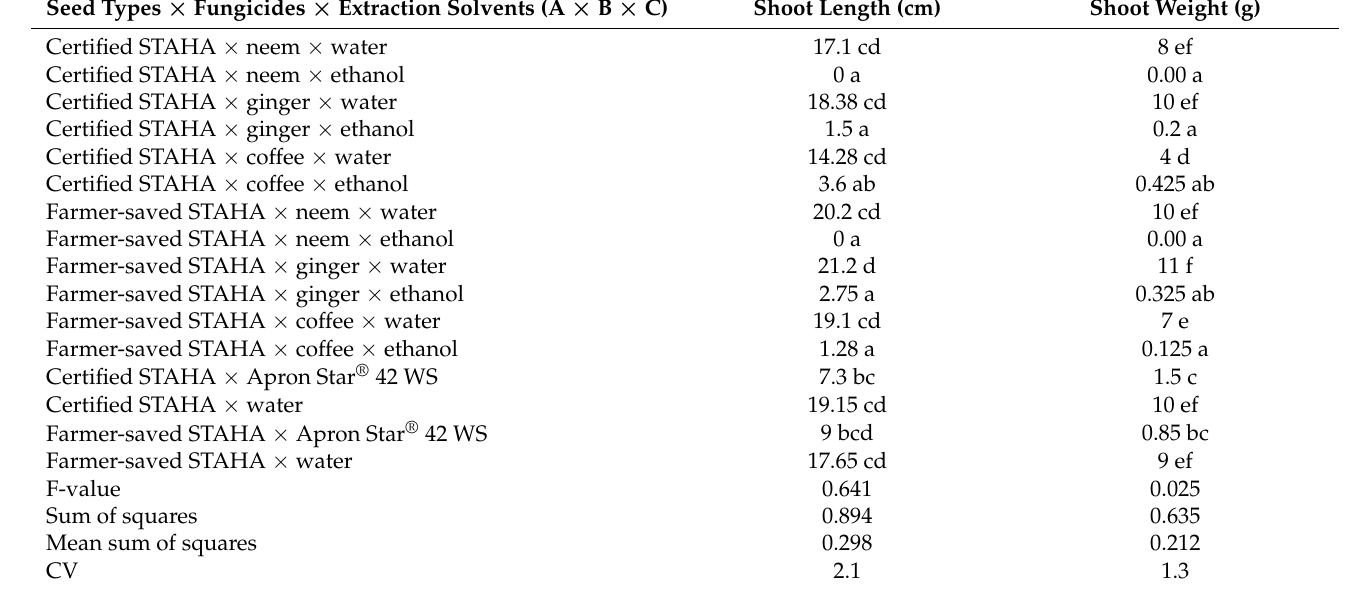
Table 1. Effects of a three-way interaction between seed types, fungicides, and extraction solvents on shoot length and shoot